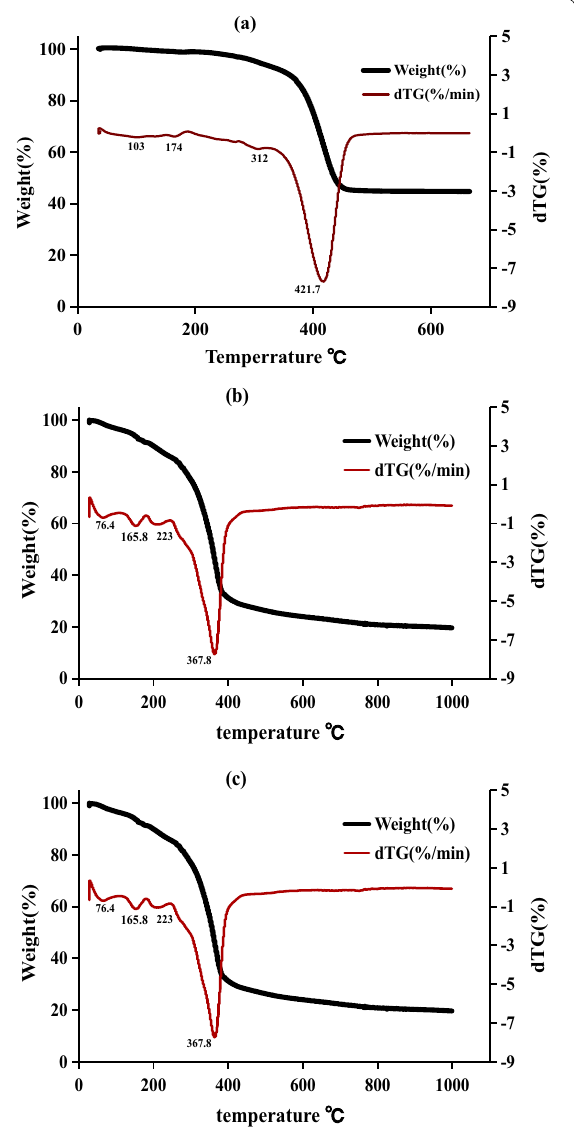
Fig. 5 TGA of copolymer ( a ), aniline graft ( b ) and 2‑chloroaniline graft ( c